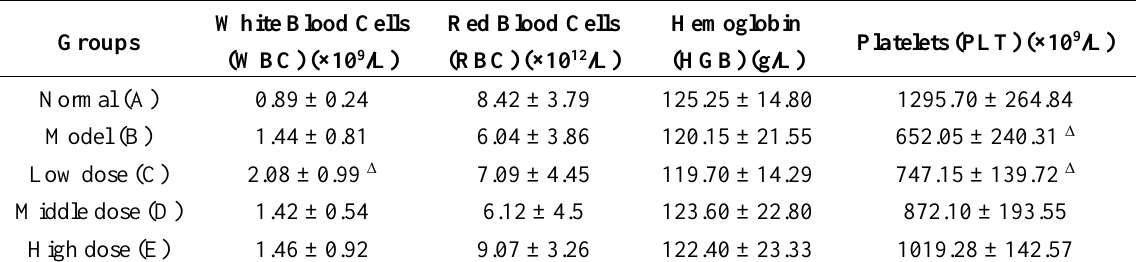
Table 3. Results of blood cell tests of mice from each of the five groups ( n = 10, x ± s). Groups